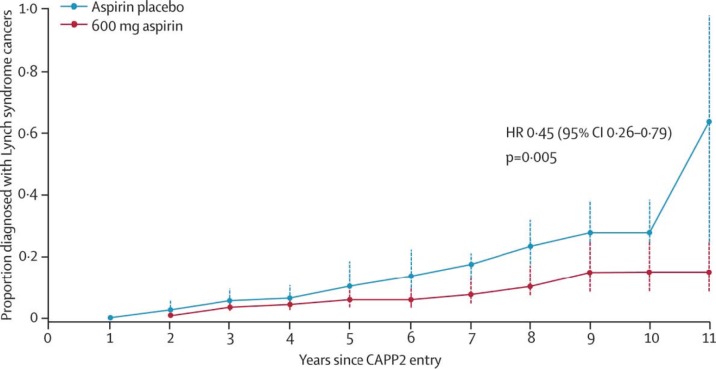
Recent evidence confirming the anti-cancer effects of aspirin. Proportion of patients developing a Lynch Syndrome related cancer over time in the randomised-placebo controlled CAPP2 trial [14]. Participants received aspirin (600 mg daily) or a placebo. with the analysis restricted to those who took trial treatment for 2 years or more. From Burn J et al (2012) Long-term effect of aspirin on cancer risk in carriers of hereditary colorectal cancer: an analysis from the CAPP2 randomised controlled trial Lancet 378 (9809), 2081-7. Reprinted with kind permission from Elsevier.